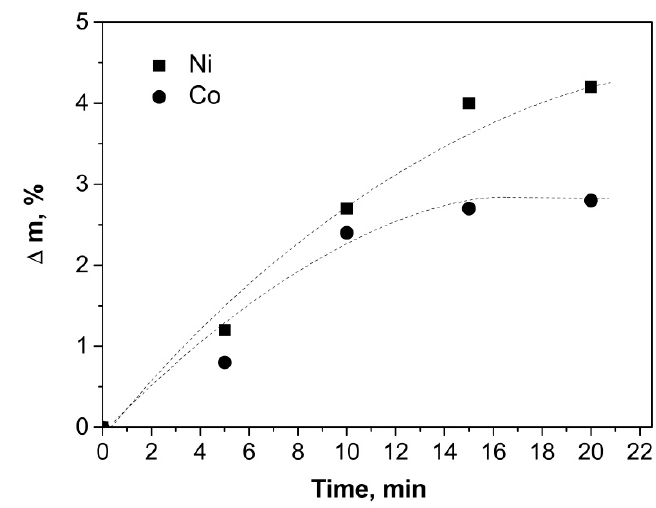
Figure 5. Dependence of the specimen mass variation on the synthesis time at 550 °C with Ni and Co catalysts.